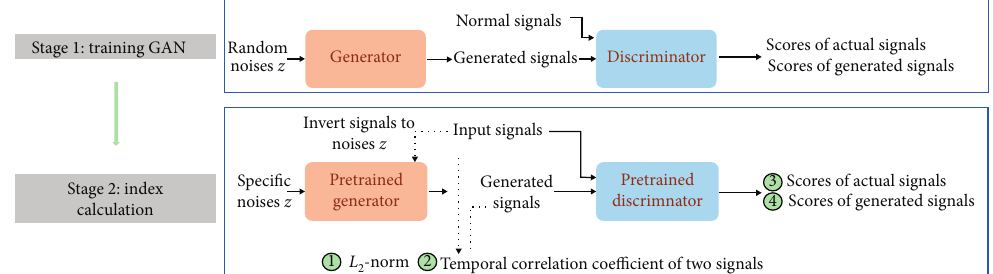
Figure 2: The overall framework of the MI-GAN. In stage 1, the generative adversarial network is trained. Stage 2 makes full use of the pretrained model to calculate four specific